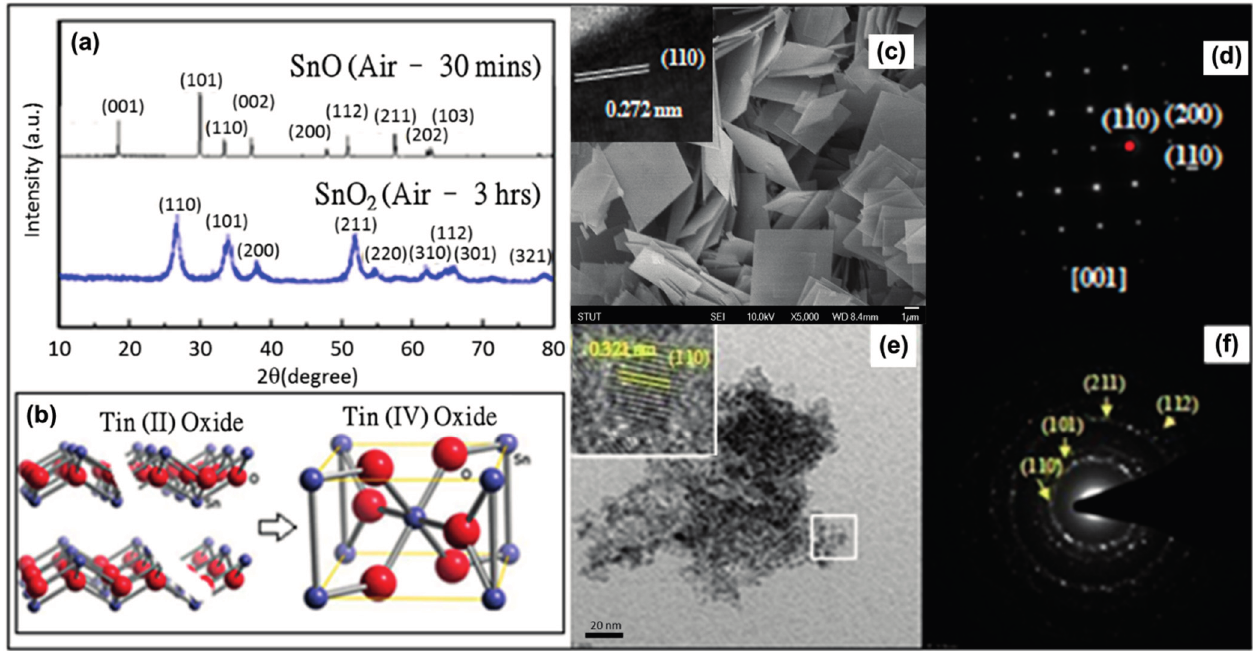
Figure 1. ( a ) XRD of nanocrystals obtained after a reaction temperature of 30 min and 3 h in air; ( b ) Schematic of crystal structure during phasic transformation of tin oxide to tin dioxide; ( c ) Bright-field TEM image and HRTEM (inset) of SnO nanosheets; ( d ) SAED image of SnO nanosheets; ( e ) Bright-field TEM image and HRTEM (inset) of SnO